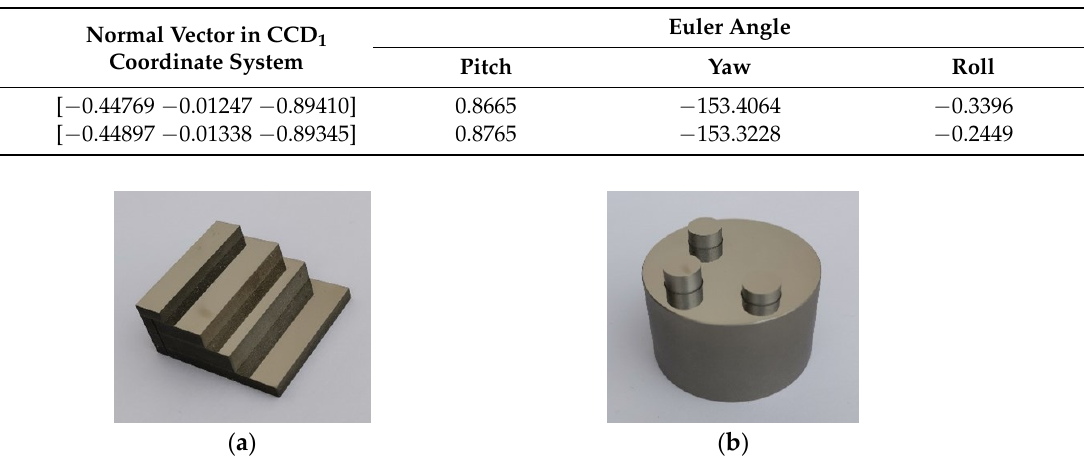
Table 1. The normal vector of LCD screens (units: ◦ ).